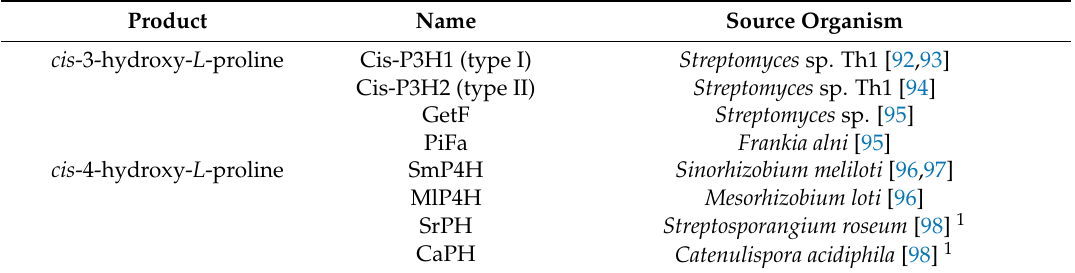
Table 1. List of proline hydroxylases classified according to their substrate preference (not